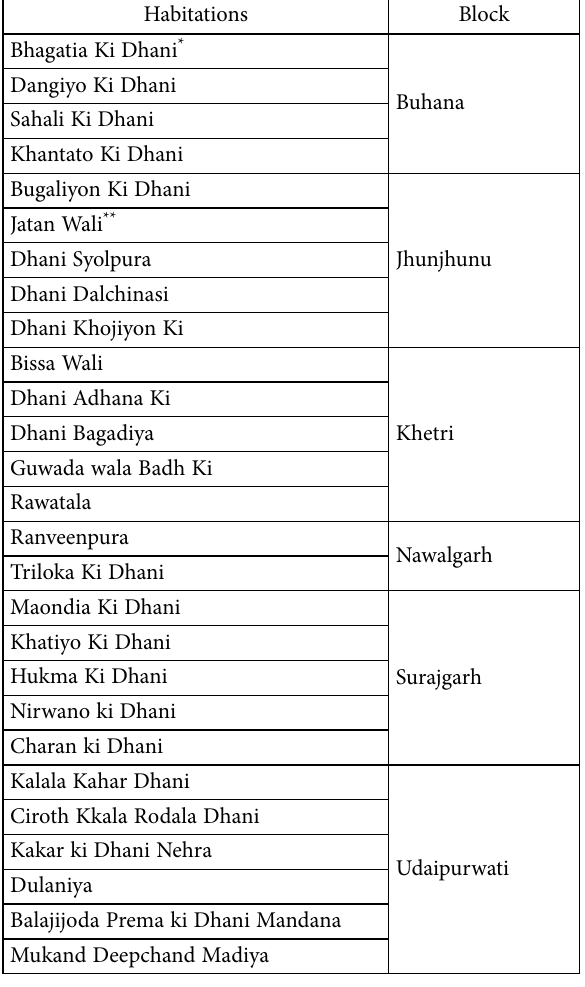
Table 1. Habitations and blocks of the study area Habitations